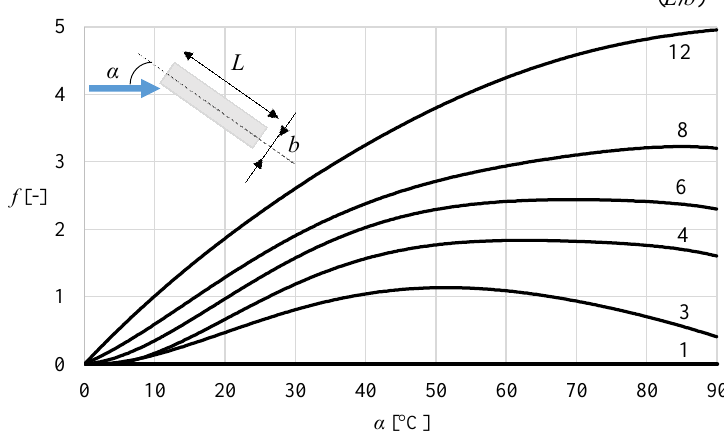
Figure 7. Coefficient f dependency on pier length to width ratio ( L / b ) and the angle the axis of the pier with the direction of the flow α.